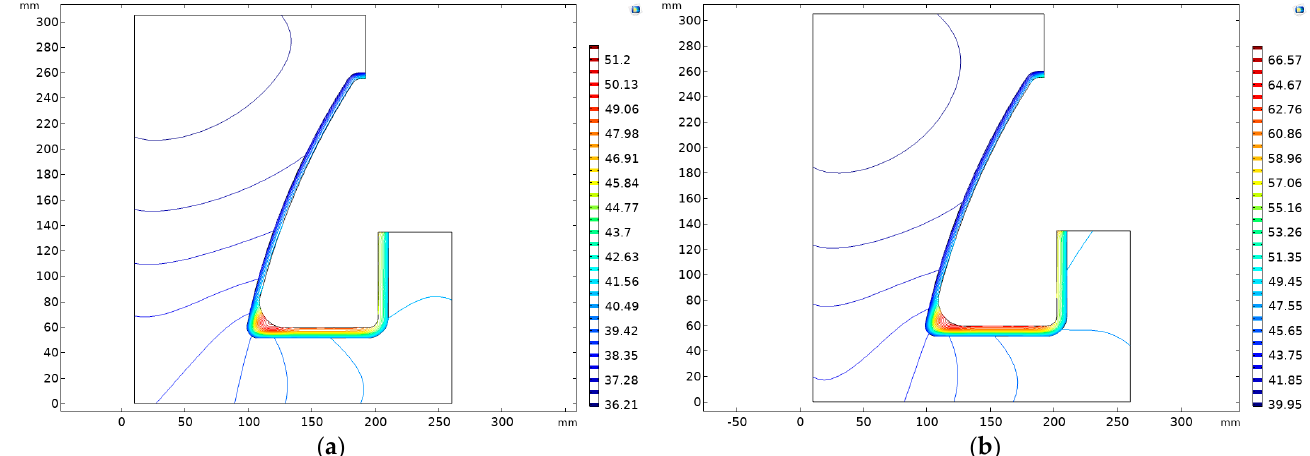
Figure 9. Isothermal curves for α = 0.95: ( a ) Tmax 60 °C and ( b ) Tmax 100 °C.